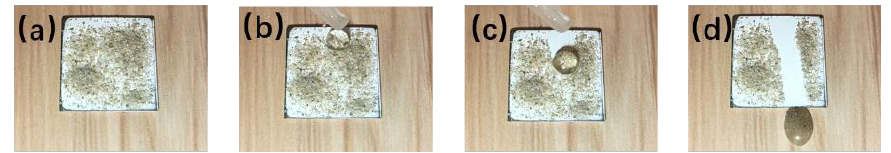
Figure 10. Self-cleaning process of superhydrophobic coating surface: ( a ) chalk dust was spread on the surface of the coating, ( b ) chalk dust adhering to the surface of the coating migrates to the surface of the droplets, ( c ) the water droplets roll off and carry away the chalk dust from the surface, and ( d ) the surface restored to its original clean state. Figure 11. Self-cleaning process of superhydrophobic coating surface: ( a ) sand was spread on the surface of the coating, ( b ) sand adhering to the surface of the coating migrates to the surface of the droplets, ( c ) the water droplets roll off and carry away the sand from the surface, and ( d ) the surface restores to its original clean state.